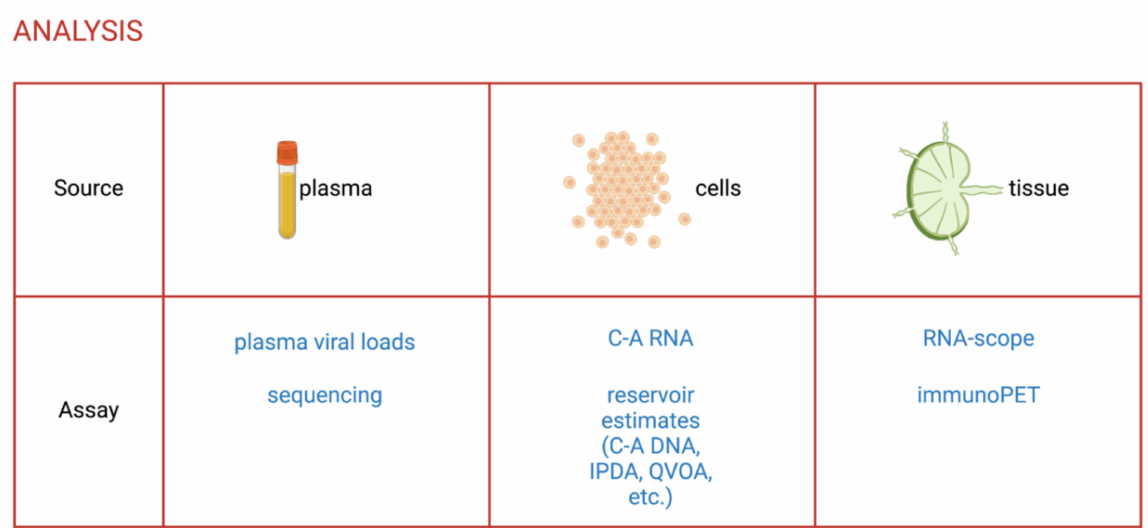
Figure 2. Assays to evaluate the efficacy of LRAs in NHPs. C-A, cell-associated; IPDA, intact proviral DNA assay; QVOA, quantitative viral outgrowth assay. Created with